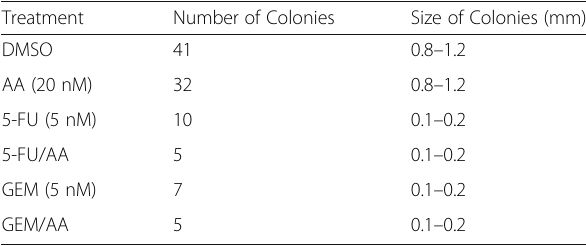
Table 1 AA increased the effect of 5-FU and GEM in 3D spheroid formation assays